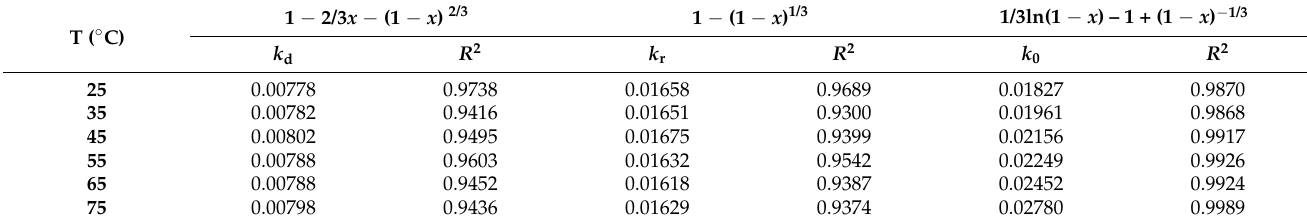
Table 2. Correlation coefficients of fitting results for various models at various temperatures.